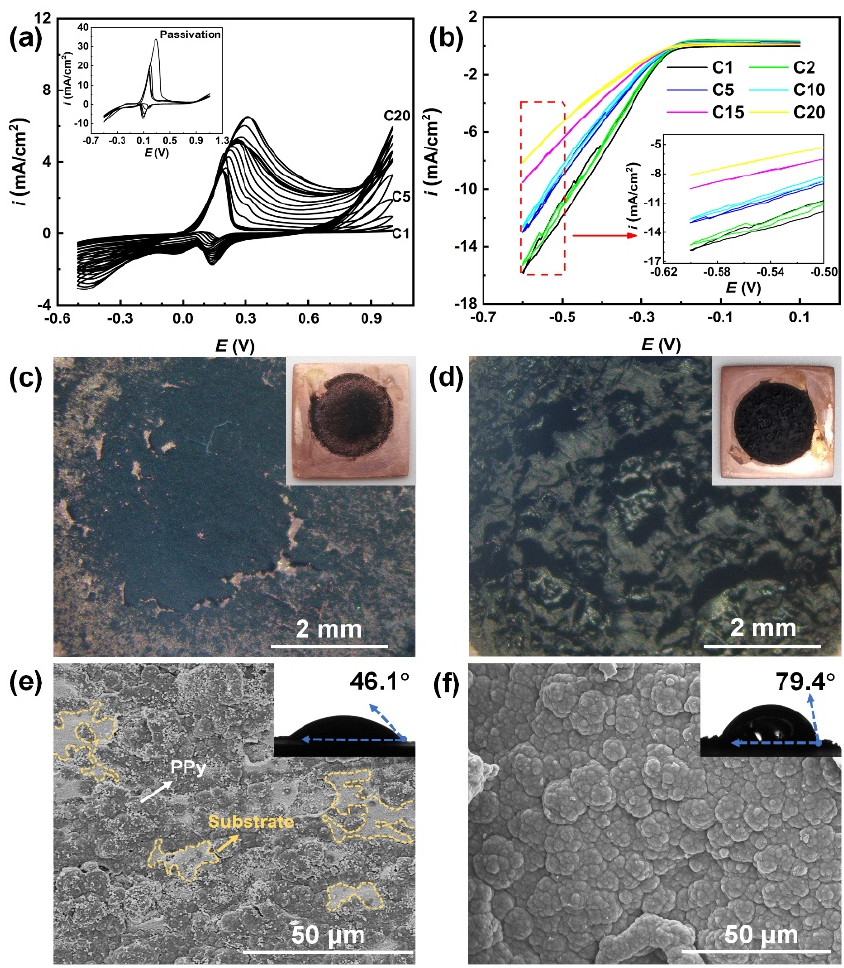
Figure 2. Voltammograms (upper), optical (middle) and SEM images (lower, wettability: inset) of PPy-T ( a , c and e ) and PPy-I coatings ( b , d and f ) deposited on copper.